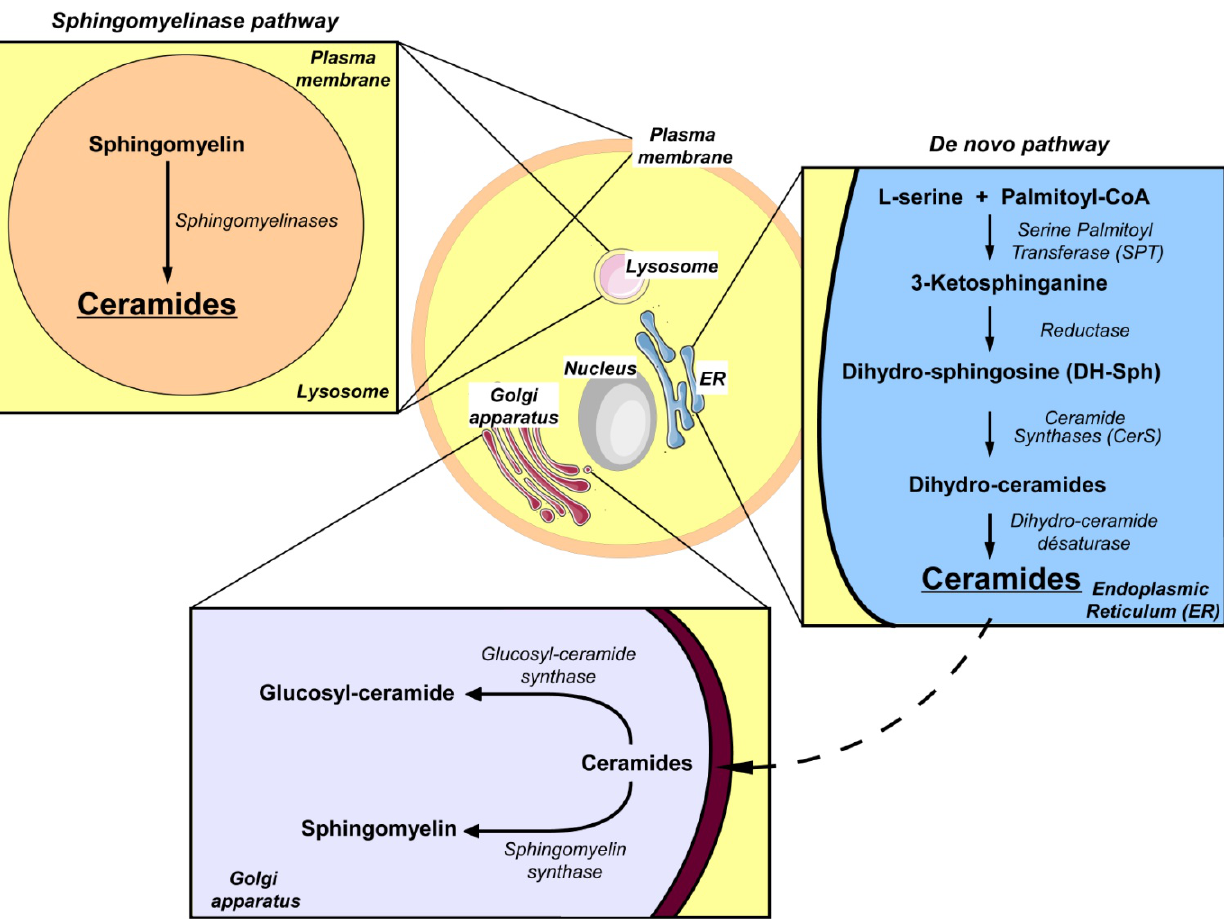
Figure 1. Synthesis of sphingolipids in mammalian cells. Two main pathways to produce sphingolipids exist in mammals. The de novo pathway of synthesis starts on the cytoplasmic face of the endoplasmic reticulum (ER). The first step of this pathway is the condensation of L -serine with palmitoyl-CoA to form a 3-ketosphinganine. This reaction is catalyzed by serine palmitoyl-transferase (SPT). 3-Ketosphinganine is then reduced to form dihydrosphingosine (DH-Sph) by 3-ketopshinganine reductase. DH-Sph is a substrate of ceramide synthases (CerS) which produce dihydro-ceramide. Dihydroceramides are transformed into ceramides by dihydroceramide desaturase. Ceramide can be transported to the Golgi apparatus to be transformed into more complex sphingolipids such as sphingomyelin and glucosyl-ceramides. A second synthesis pathway is the catabolic pathway that leads to the degradation of sphingomyelin (SM) into ceramides by sphingomyelinases. This process takes place in the lysosomal and plasma